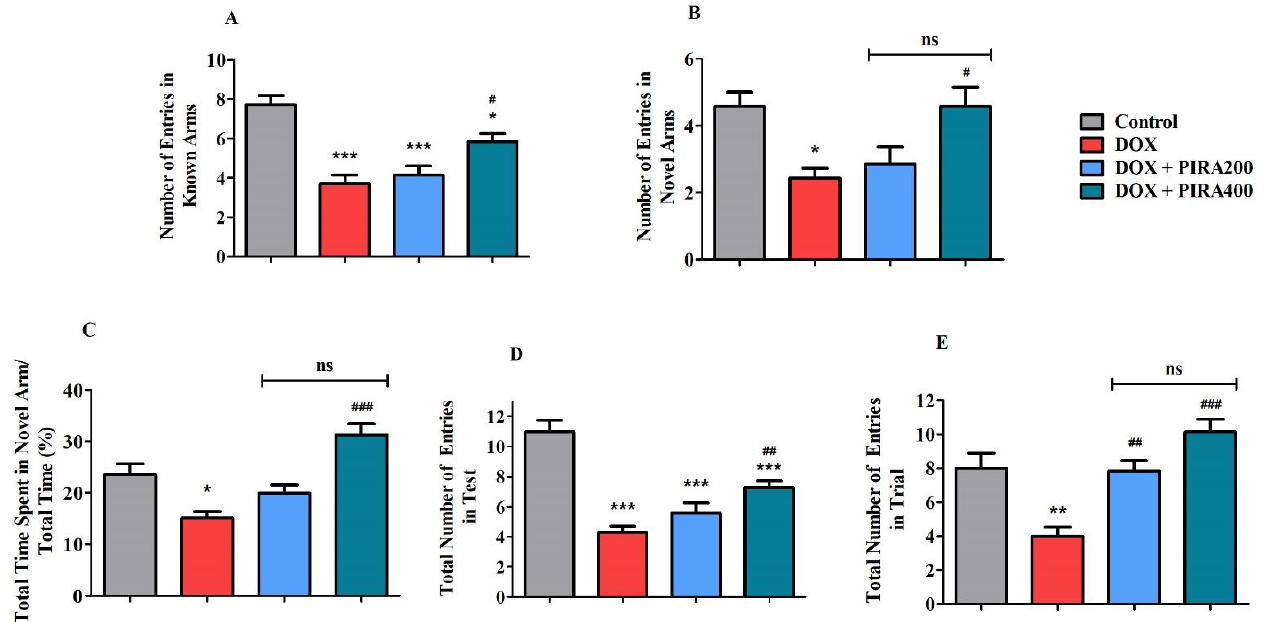
Figure 3. Effect of piracetam (PIRA) on ( A ) the number of entries in known arms in the test session, ( B ) the number of entries in the novel arm in the test session, ( C ) the percentage of time spent in the novel arm in the test session, ( D ) the total number of entries in the test, and ( E ) the total number of entries in the trial session of the doxorubicin (DOX)-induced rat model using a Y-maze. The results are expressed by mean ± SEM ( n = 7). A one-way ANOVA [ F (3,24) = 17.60, p < 0.001 for the number of entries in the known arms; F (3,24) = 5.929, p < 0.01 for the number of entries in a novel arm; F (3,24) = 14.43, p < 0.001 for the percentage of time spend in novel arm; F (3,24) = 24.37, p < 0.001 for the total number of entries in the test; F (3,24) = 13.12, p < 0.001 for the total number of entries in the trial] was conducted, followed by a Tukey–Kramer multiple comparisons test. * p < 0.05, ** p < 0.01, group; # p < 0.05, ## p < 0.01, and ### p < 0.001 as compared to the DOX-induced